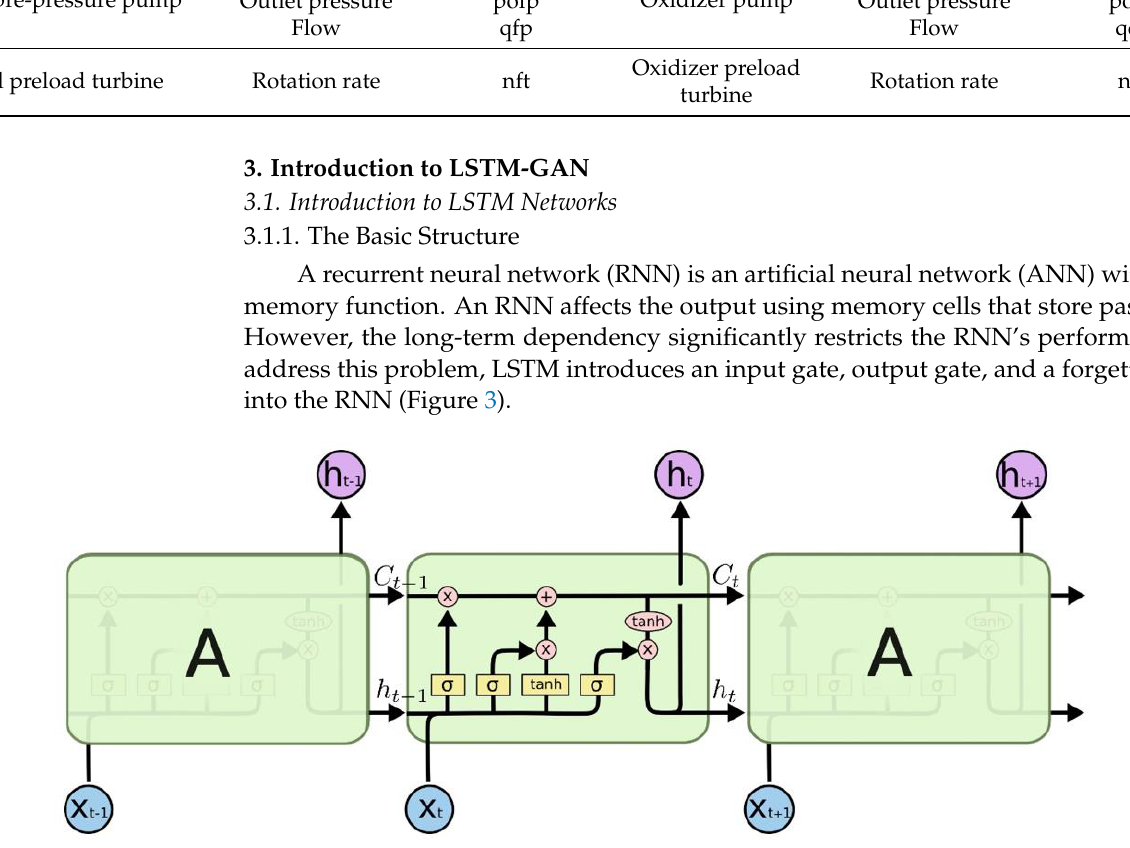
Figure 3. The LSTM structure.